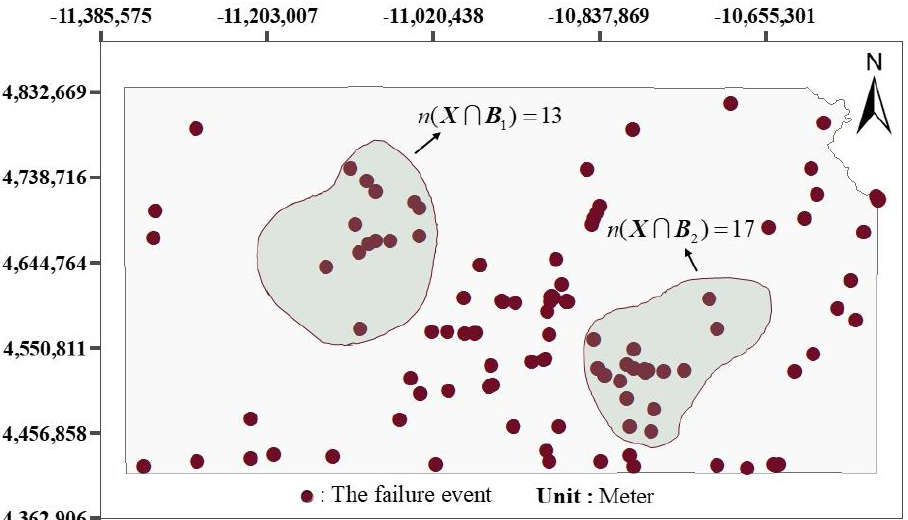
Figure 2. Distribution of pipeline failure events in Kansas.